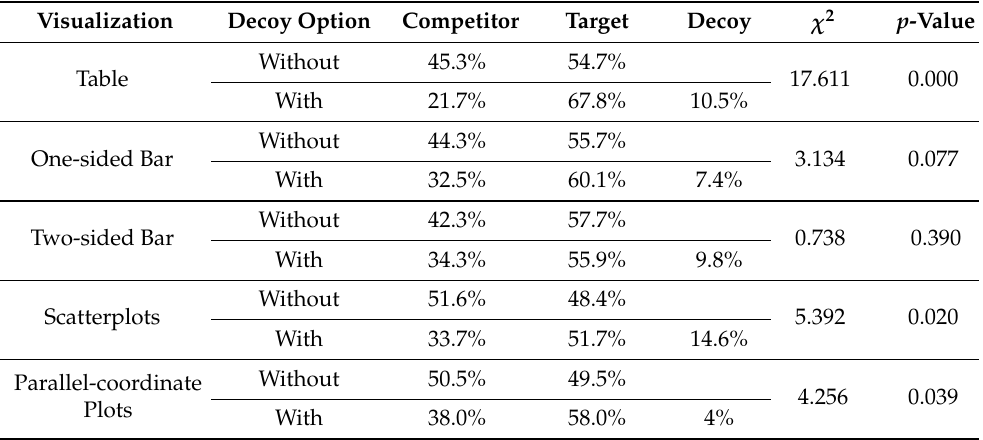
Table 4. Summary of choice probabilities for decoy placement for each